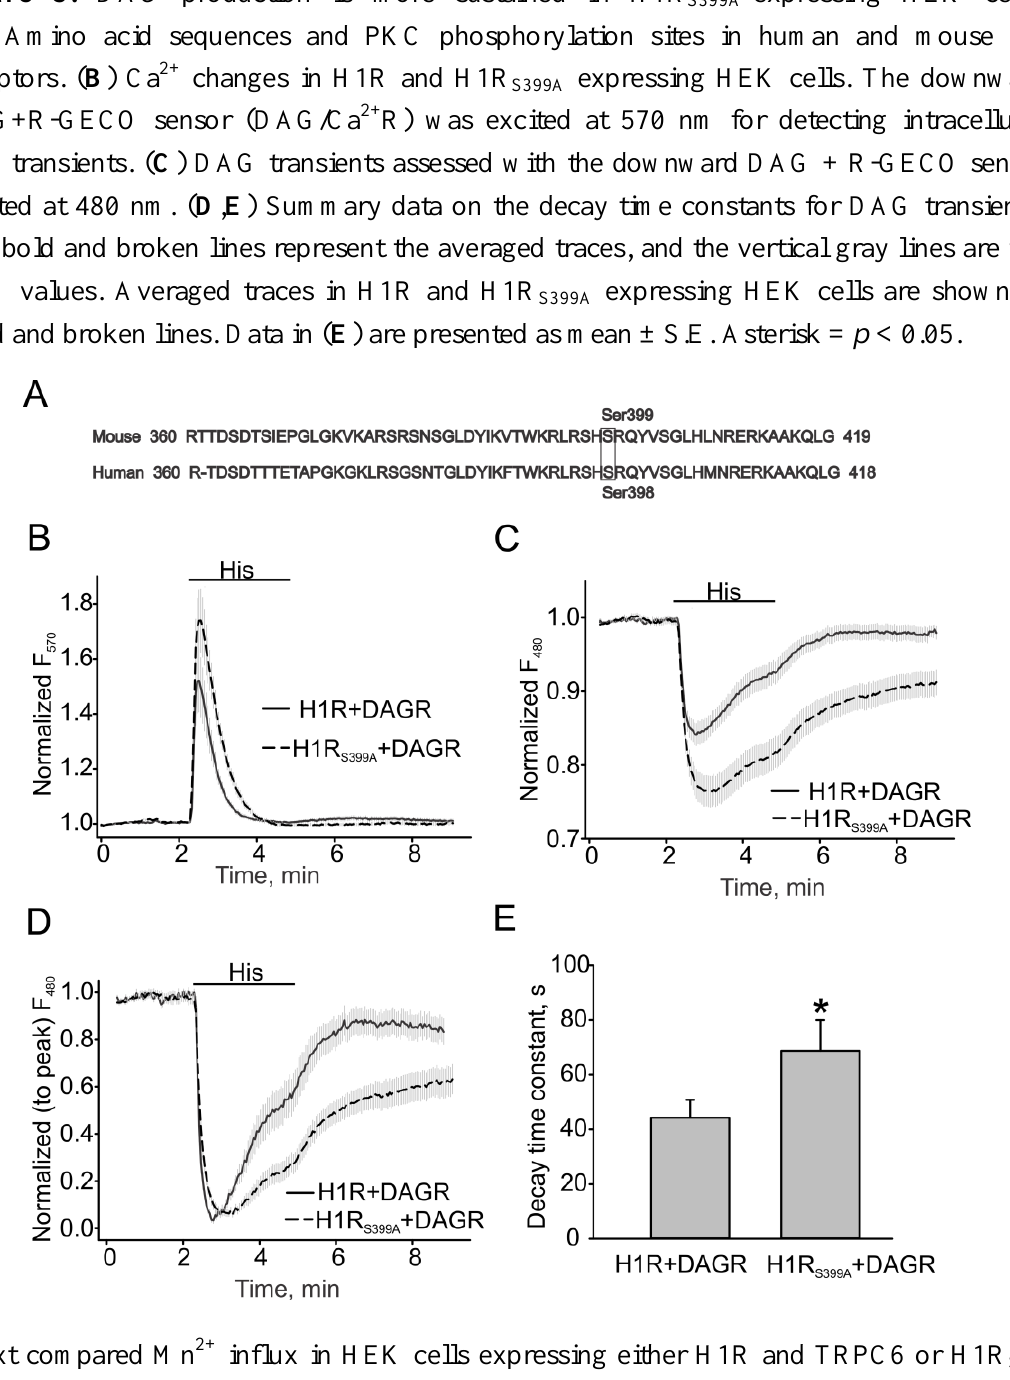
Figure 3. DAG production is more sustained in H1R